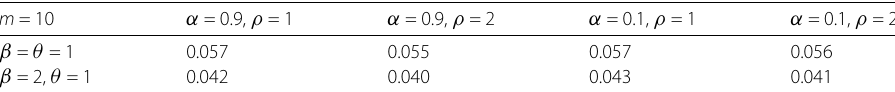
Table 2 Maximum error of approximation: (cid:7) g – U β , θ , ρ m , α ( g ; y ) (cid:7) ∞ m = 10 α = 0.9, ρ = 1 α = 0.9, ρ = 2 α = 0.1, ρ = 1 α = 0.1, ρ = 2 β = θ =